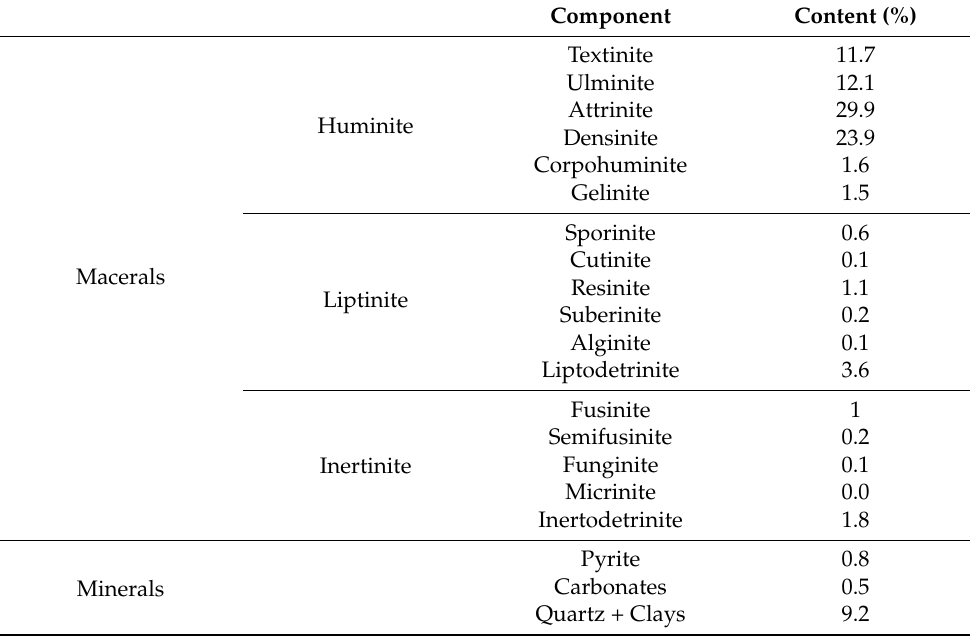
Table 1. Petrographic composition of lignite from the Szczerc ó w